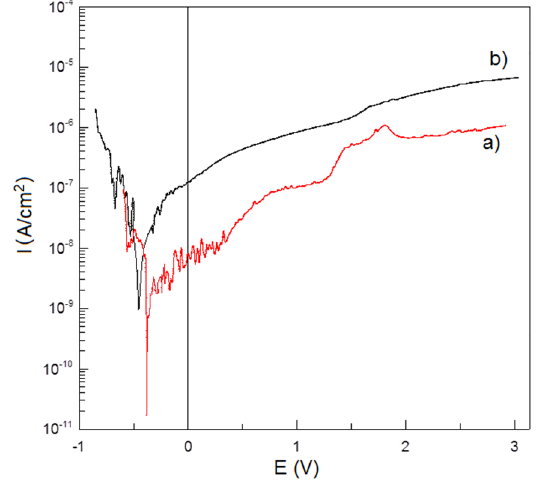
Figure 7. Potentiodynamic polarization curves of: Ti-10 wt% 45S5 Bioglass-1 wt% Ag nanocomposite foam with porosity of 70% ( a ) and microcrystalline titanium ( b ) in Ringer’s solution at 37